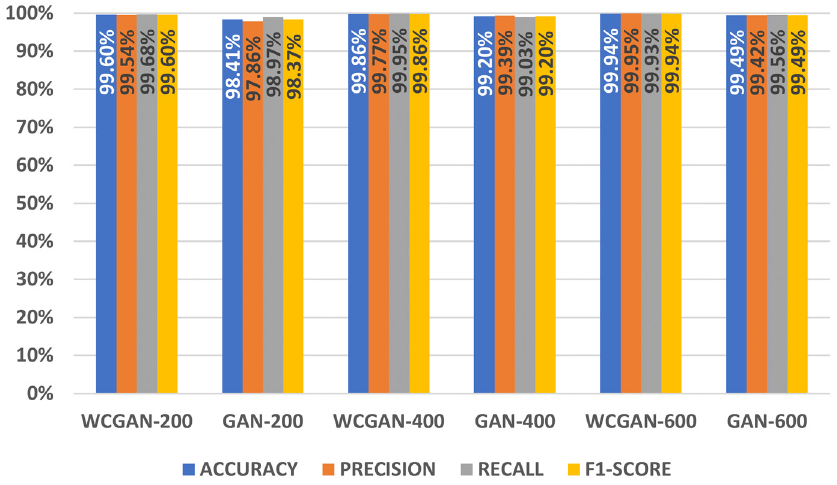
Figure 13. Histograms of the performance of our new GB-based classifiers on our new generated test sets.